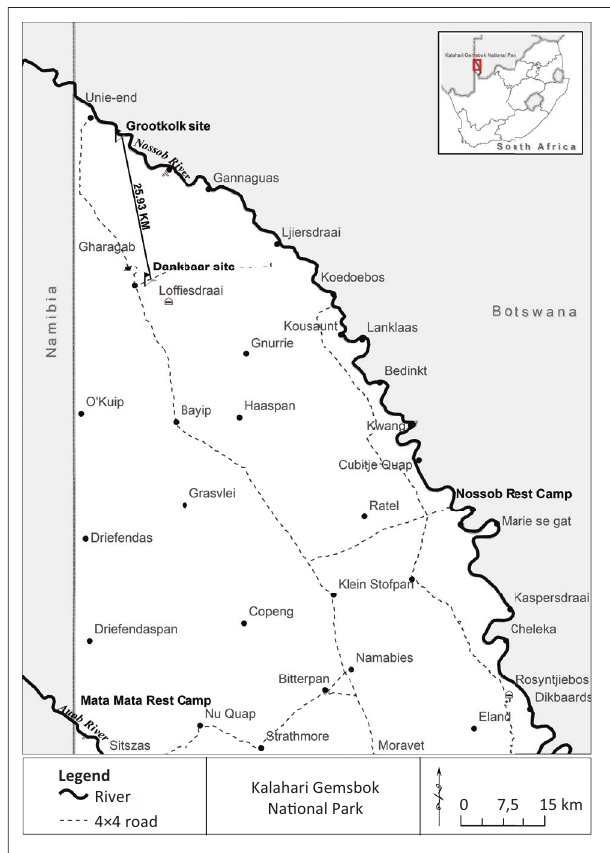
FIGURE 1: Location of the two Vachellia erioloba study sites, Dankbaar situated in the interior duneveld and Grootkolk located in the Nossob riverbed, within the Kalahari Gemsbok National